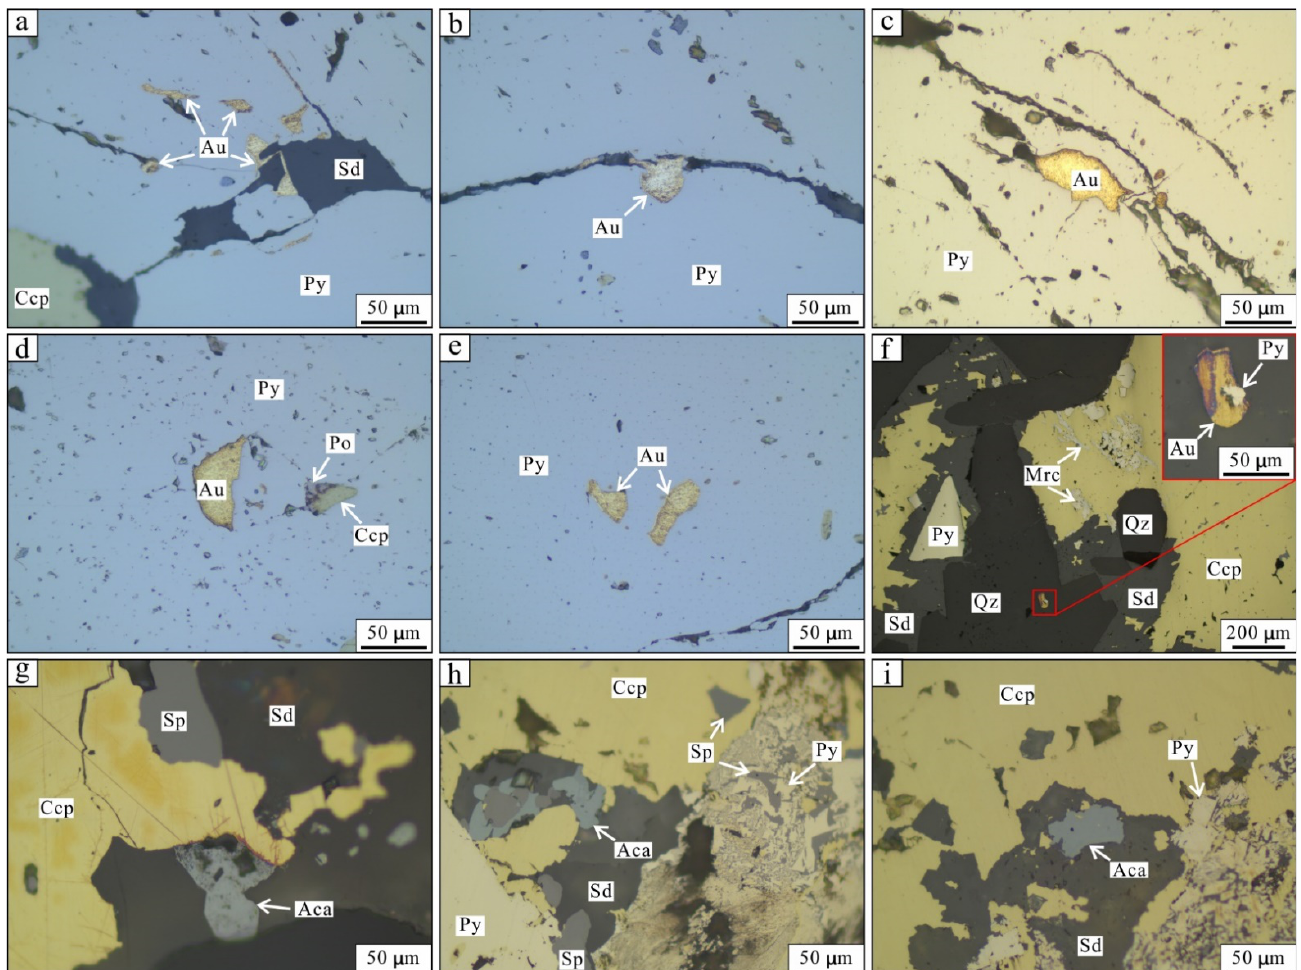
Figure 4. Photomicrographs of gold ( a – f ) and acanthite ( g – i ) grains. ( a – c ) Gold grains in the fractures of pyrite. ( d , e ) Gold grains as inclusions within pyrite. ( f ) Gold grain as inclusion within quartz. ( g – i ) Acanthite grains showing irregular shapes. Abbreviations are the same as those in Figure 3.